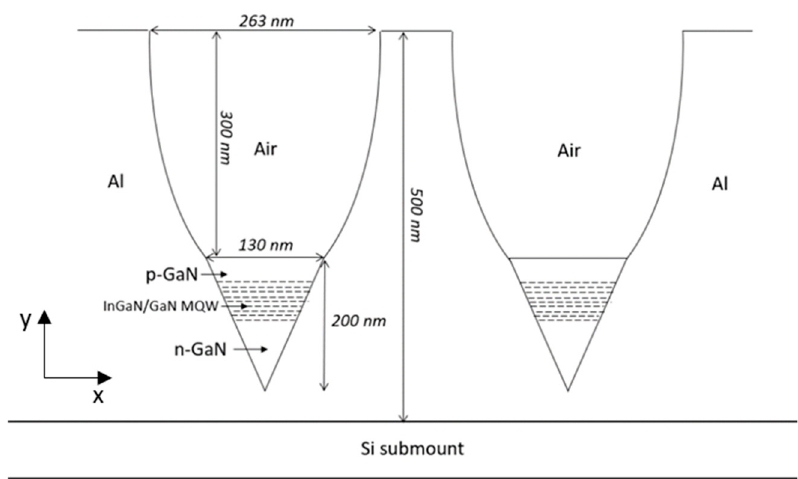
Figure 2. Presentation of a cross section of an array of two adjacent LENS devices with reduced dimensions. The design includes a reflective Coned Nano-Green LED with a Compound Parabolic Concentrator (CPC).